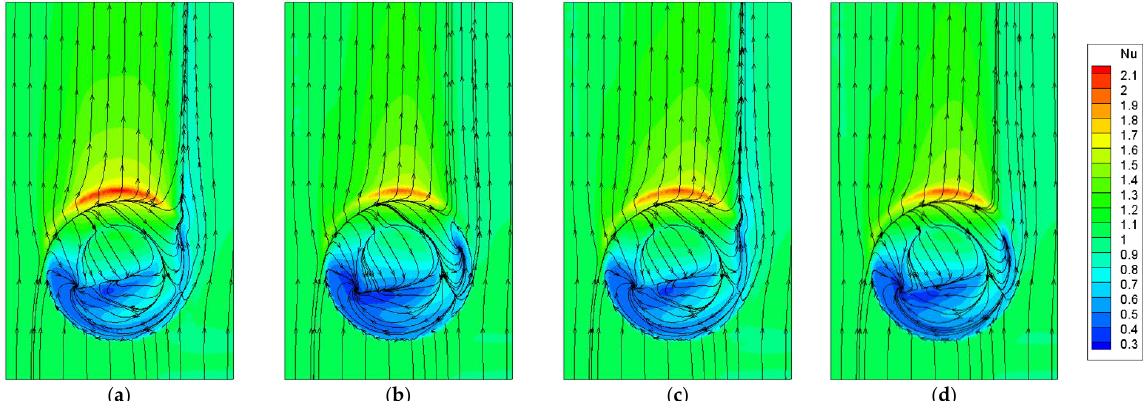
Figure 5. Calculated fields of the relative Nusselt numbers 𝑁𝑢/𝑁𝑢 𝑝𝑙 and the source streamlines in the control area of the channel wall with the dimples for the different standard SST models and the modified Menter SST models: ( a ) Menter 1993 SST model, ( b ) Menter 2003 SST model, ( c ) Menter SST model corrected according to RLI, and ( d ) Menter SST model corrected according to SM.